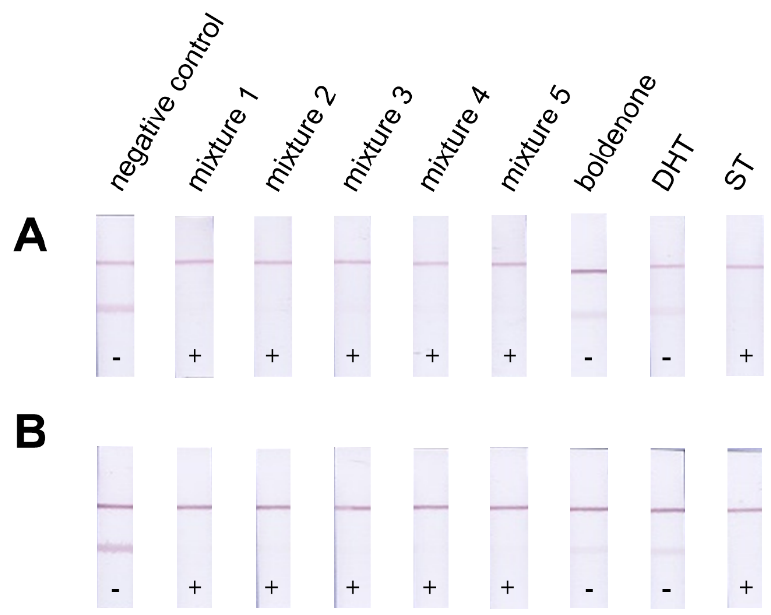
Figure 5. Result of artificially contaminated by indirect (panel ( A )) and direct format (panel ( B )).